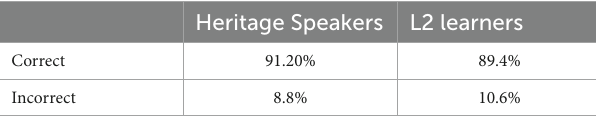
TABLE 7 Mean accuracy scores for the comprehension